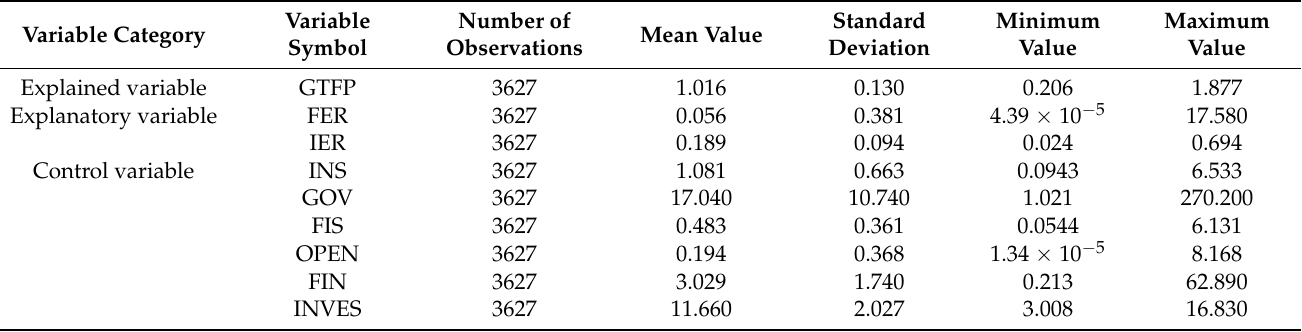
Table 2. Descriptive statistics of the main